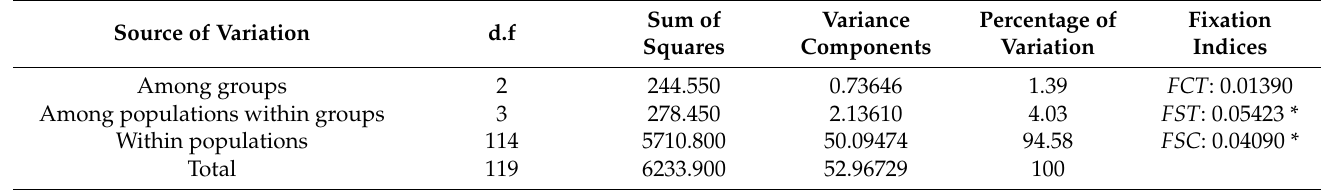
Table 2. Analysis of molecular variance of groups based in the geographical location of B. veronicifolia populations. Source of Variation